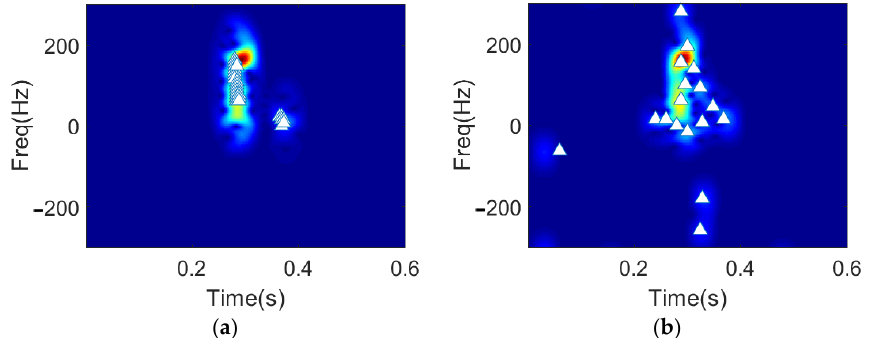
Figure 5. Demonstration of the feature vectors and the corresponding time-frequency distribution, yielded by: ( a ) DGS-SP, ( b )